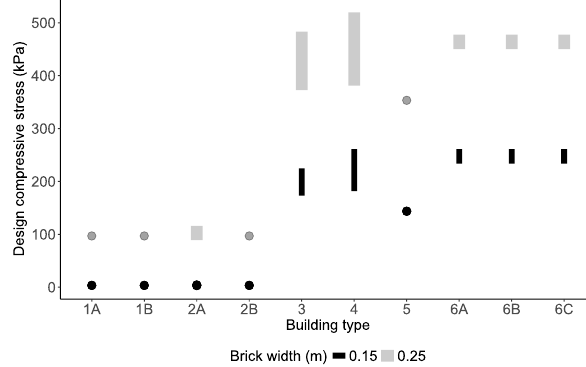
Figure 3. Range of design compressive stress for building types 1A–6C defined in Thouret et al. (2014). Compressive stress capacity was calculated for every configuration of compressive strength ( f c ) , bedded area ( A b ) and thickness coefficient ( k t ) at brick widths ( b) of 150 and